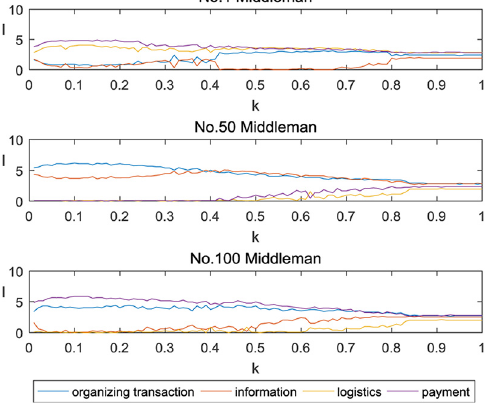
Figure 2. Degree of economic